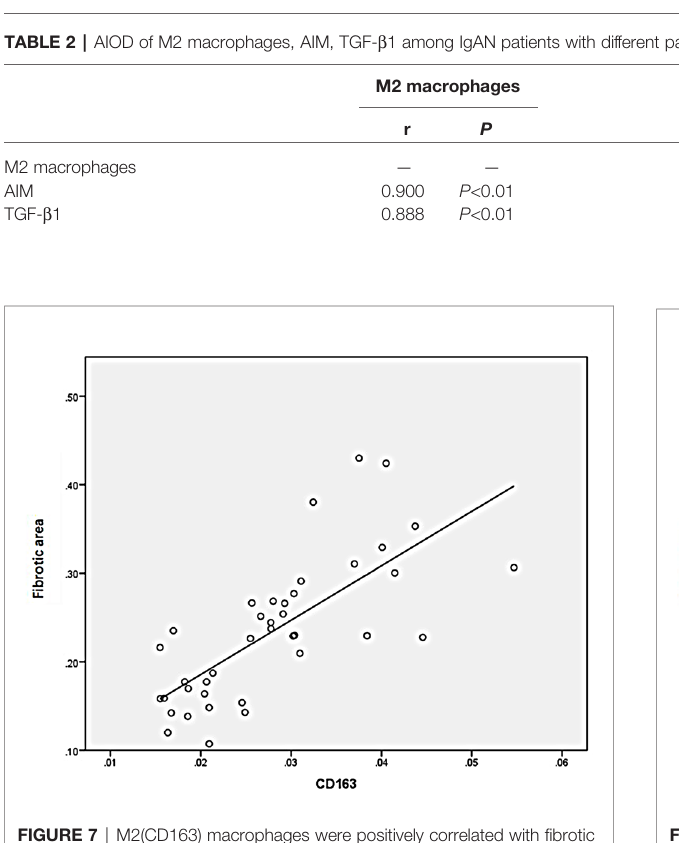
FIGURE 7 | M2(CD163) macrophages were positively correlated with fi brotic area (n=40, r=0.777, P<0.01).